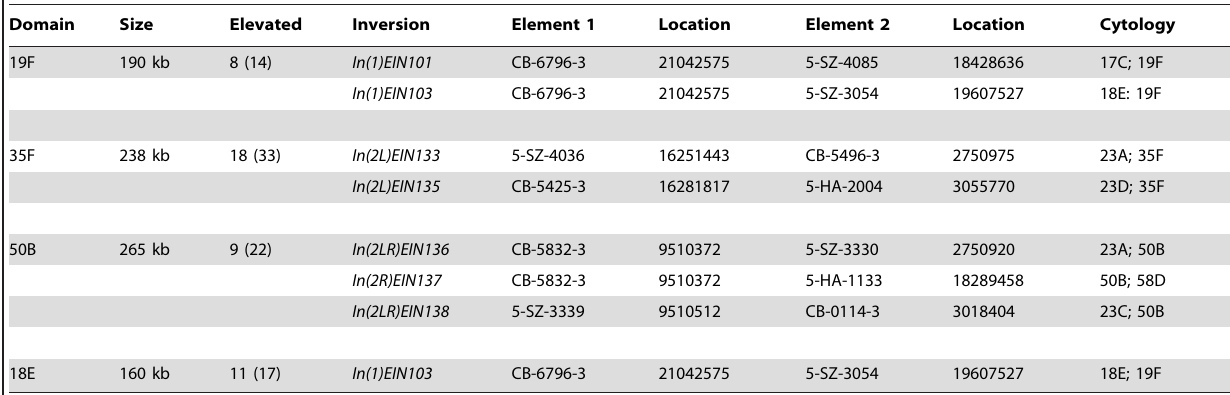
Table 1. Inversions